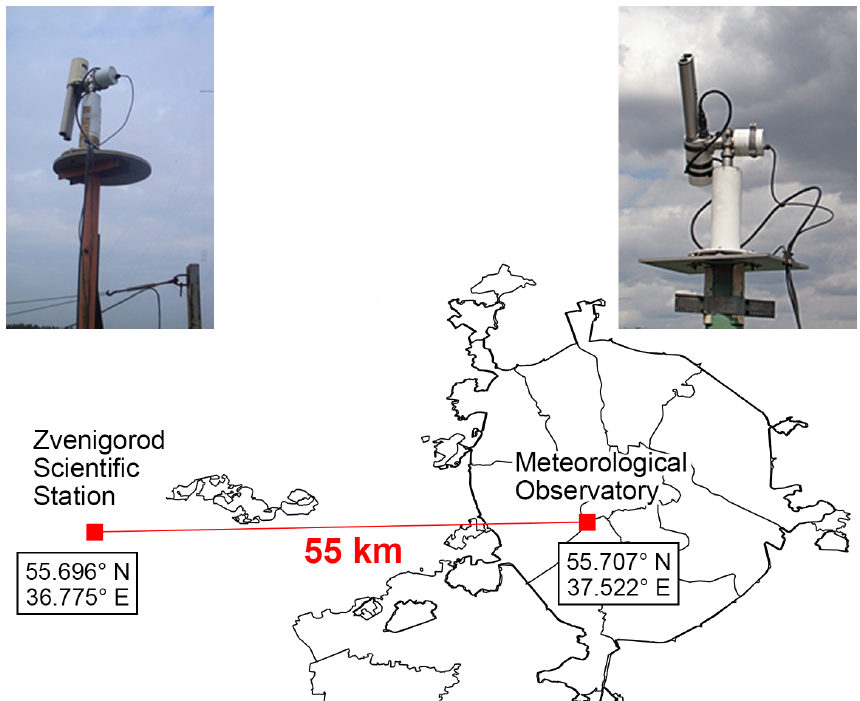
Figure 1. Location of CIMEL sun/sky AERONET photometers at the Meteorological Observatory of Moscow State University (MSU MO) and at the Zvenigorod Scientific Station (ZSS) of the A. M. Obukhov Institute of Atmospheric Physics, Moscow